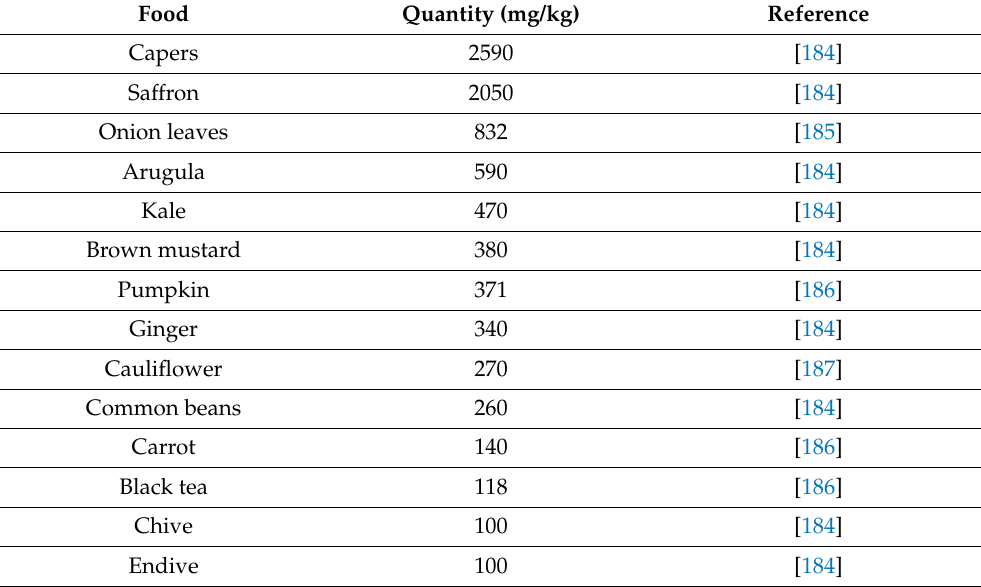
Table 2. Kaempferol content of some common foodstuffs (fresh unless otherwise